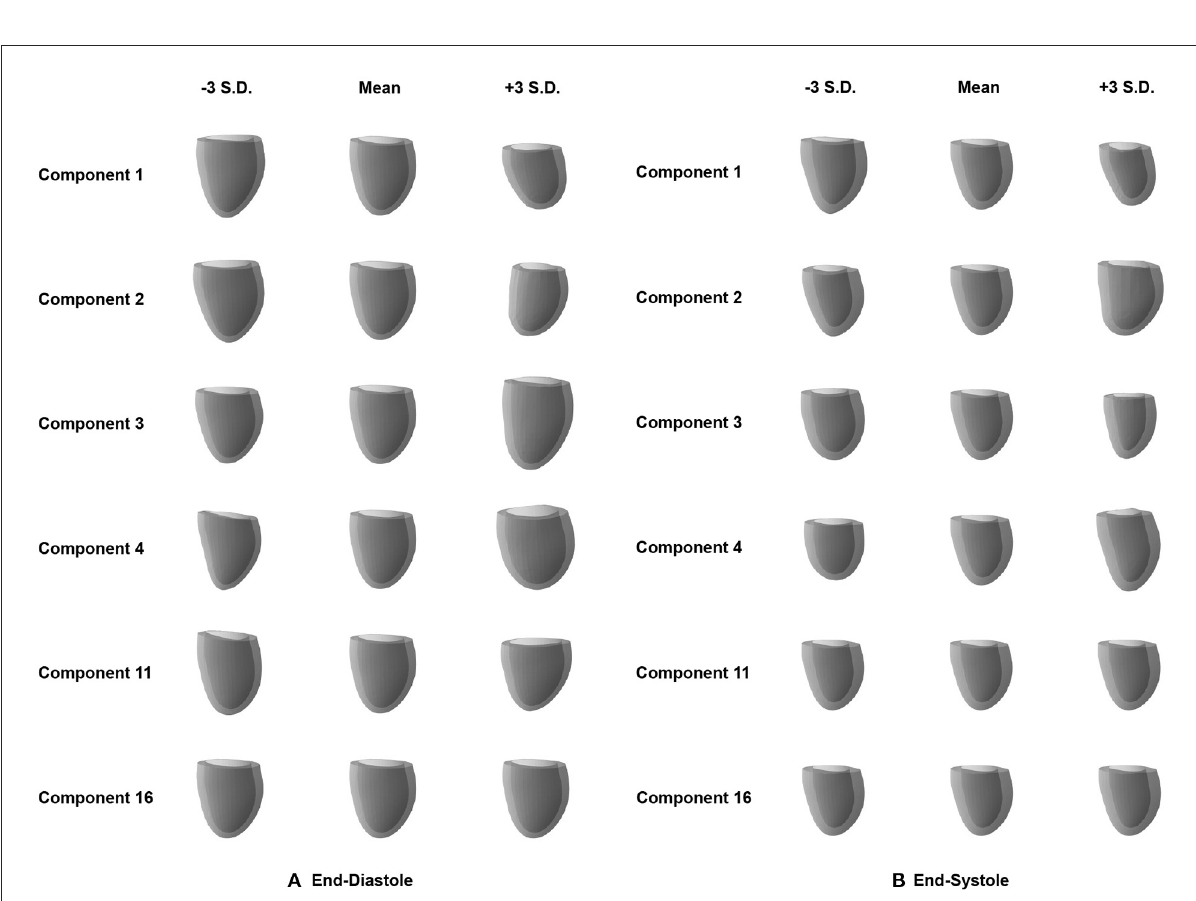
FIGURE5 Effect of changes in the individual latent space components (rows) on the 3D mesh shapes reconstructed by the decoder of the mesh VAE for ED (A) and ES (B) phases. Results are shown for the four most active latent space components (1–4), the least active one (16), and the one with the largest activity difference between ED and ES phases